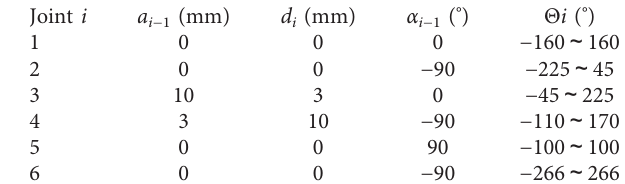
Table 1: DH parameters of ZrARM mechanical arm.